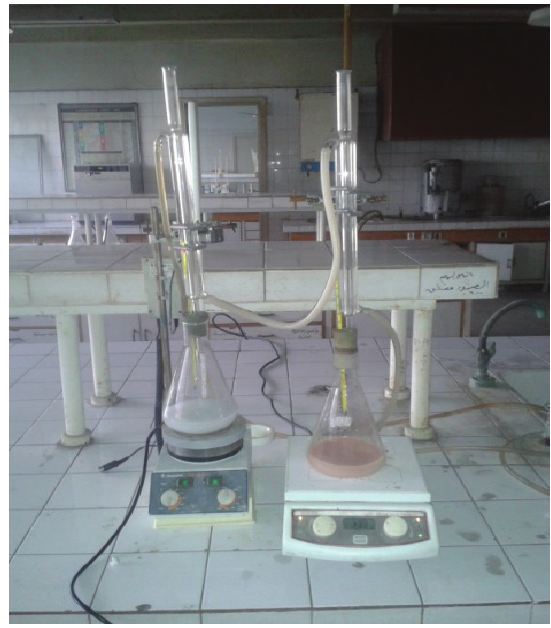
Figure 1 Photograph of the modified Chapelle test set-up.